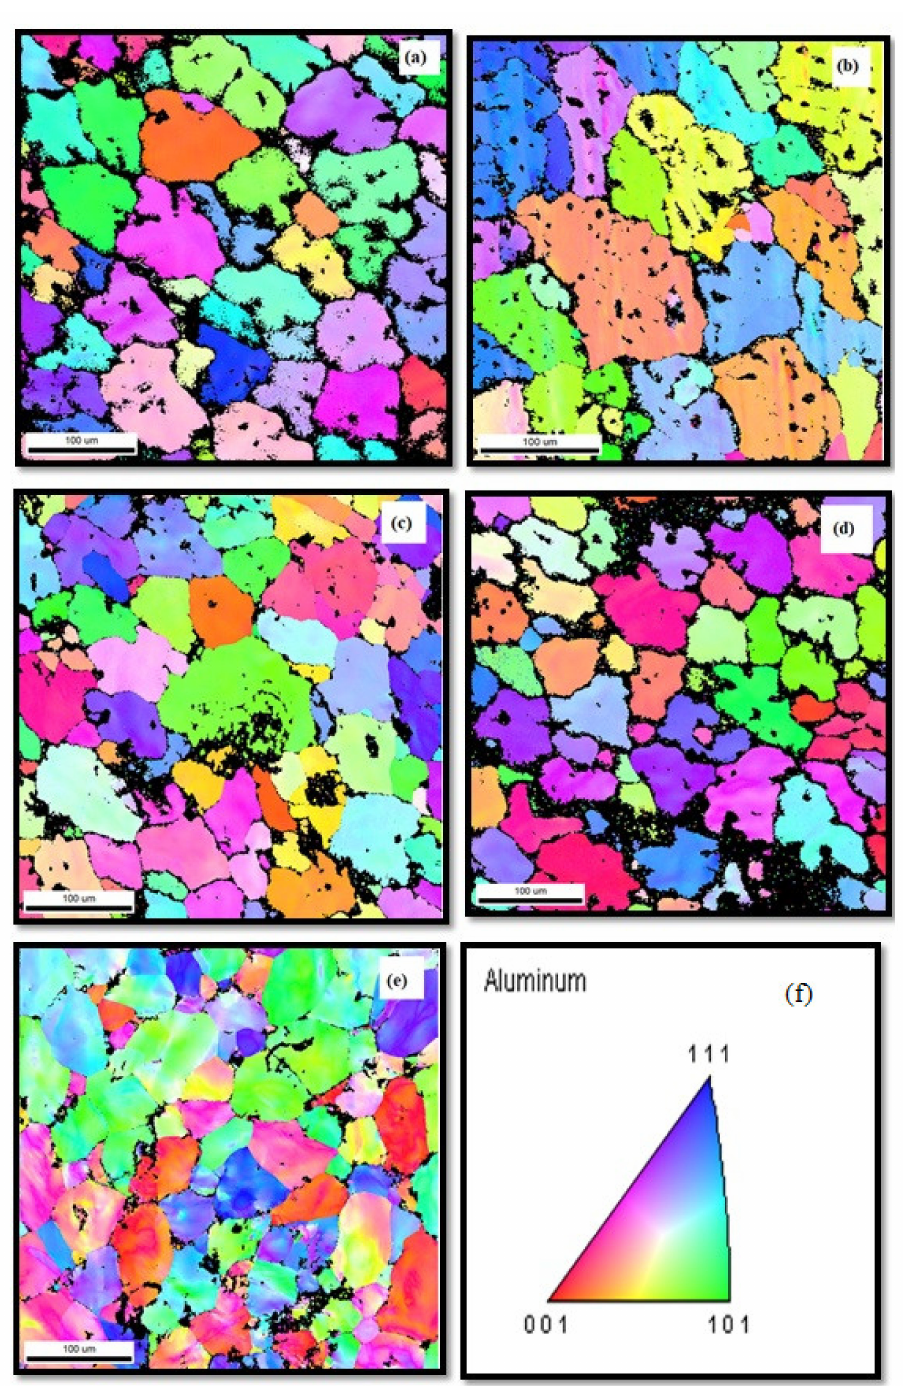
Figure 5. ( a )–( e ) Electron backscatter diffraction observations of ( a ) 0 wt.% TiB 2 , ( b ) 3 wt.% TiB 2 %, ( c ) 6 wt.% TiB 2 , ( d ) 9 wt.% TiB 2 and ( e ) 12 wt.% TiB 2 . ( f ) slope